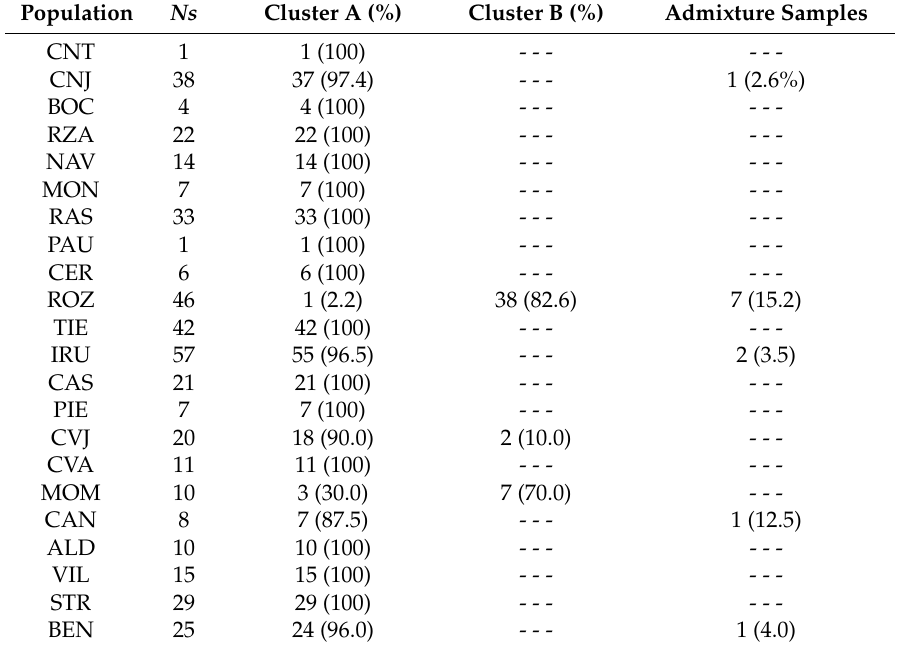
Table 6. Number and percentage of individuals assigned to clusters (A and B) or considered as admixture samples as defined by STRUCTURE analysis in each Ulmus glabra population studied. See Table 1 for population